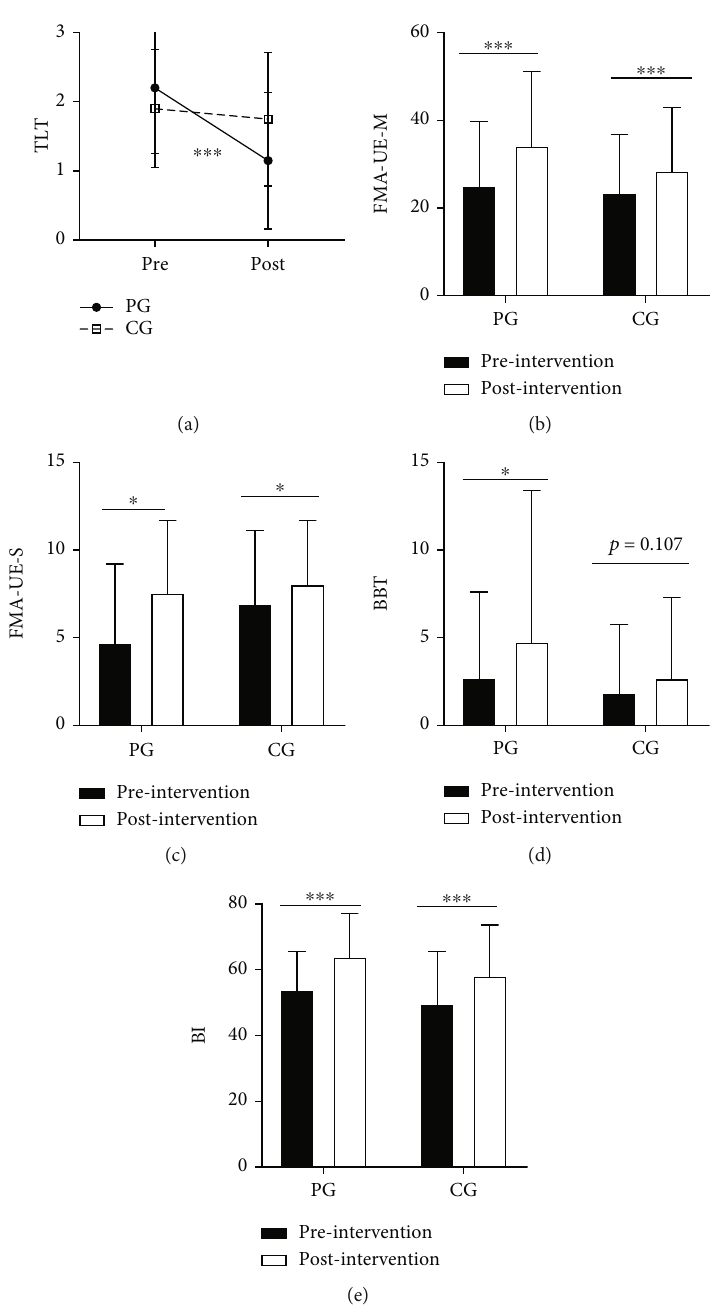
Figure 3: Group di ff erences in clinical measurements. (a) The scores of the thumb localizing test (TLT) in the two groups before (pre) and after (post) intervention. (b) The scores of the motor subscale of Fugl-Meyer assessment for upper extremity (FMA-UE-M) in the two groups before (pre) and after (post) intervention. (c) The scores of the sensory subscale of Fugl-Meyer assessment for upper extremity (FMA-UE-S) in the two groups before (pre) and after (post) intervention. (d) The scores of box and block test (BBT) in the two groups before (pre) and after (post) intervention. (e) The scores of Barthel Index (BI) in the two groups before (pre) and after (post) intervention ( ∗ p < 0 : 05 and ∗∗∗ p < 0 : 001